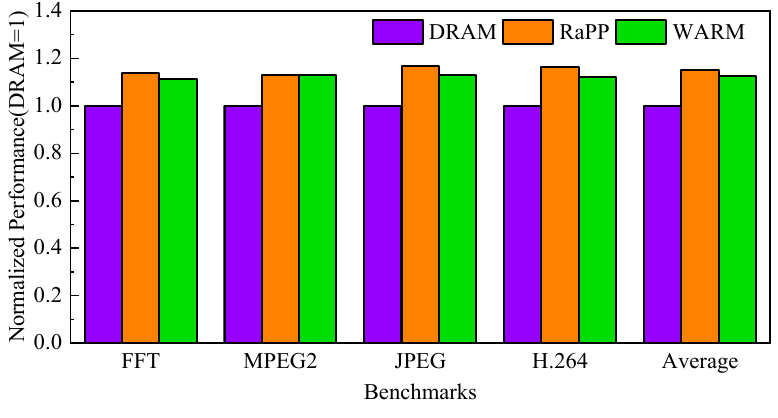
Figure 9. Normalized performance.